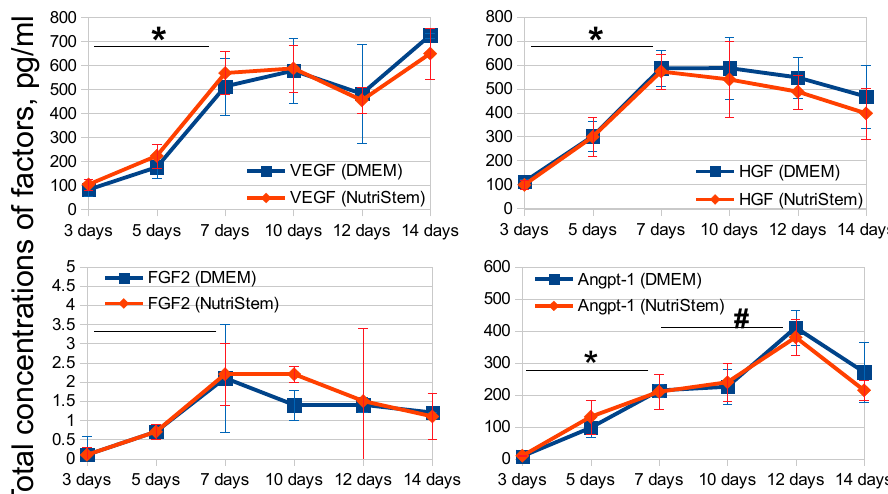
Figure 1. Total growth factor concentrations in DMEM- (blue lines) and NutriStem-based (red lines) MSC-CM samples ( n = 3) collected independently at each timepoint of MSC conditioning. The data are presented as mean concentrations in pg/mL ± SD. MSC-CM samples were analyzed in three independent replicates for both media. Only MSC-CM samples based on the same medium were compared. * p < 0.05 compared to the factor concentration at day 3, # p < 0.05 compared to the factor concentration at day 7.